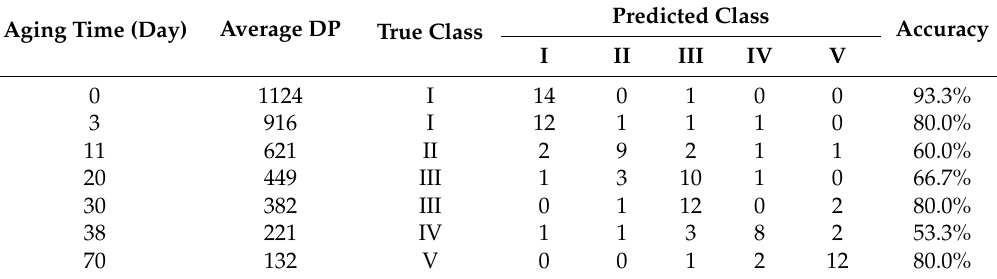
Table 2. Results of the testing experiment using